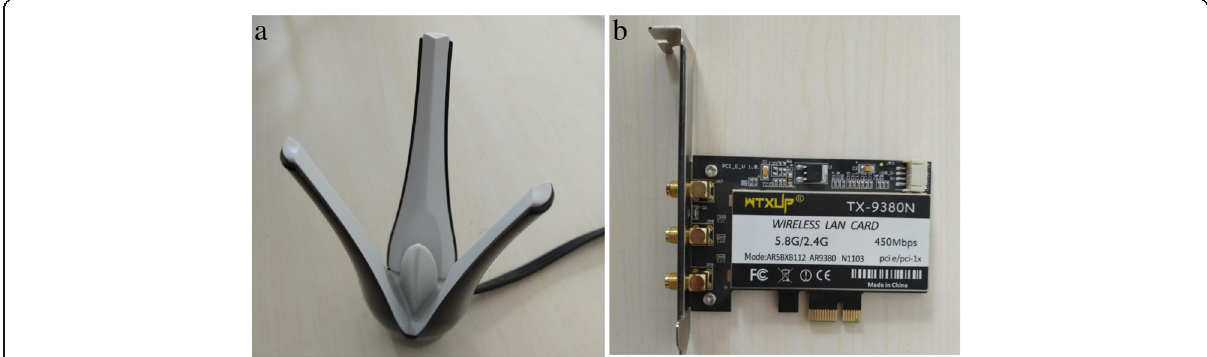
Fig. 9 The commercial hardware testbed. a Transmitter. b